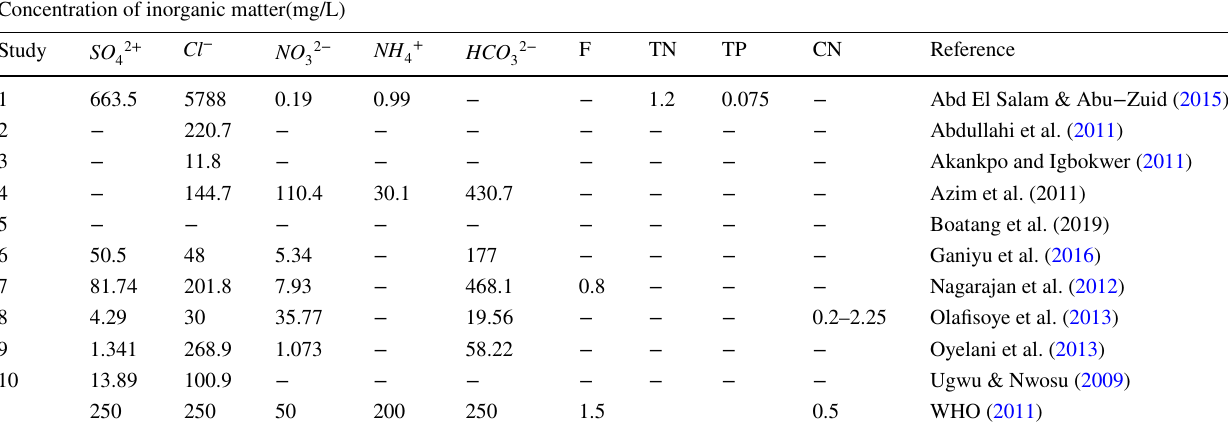
Table 5 Concentration of inorganic matters in selected refereed studies, at various dumpsites Concentration of inorganic matter(mg/L)